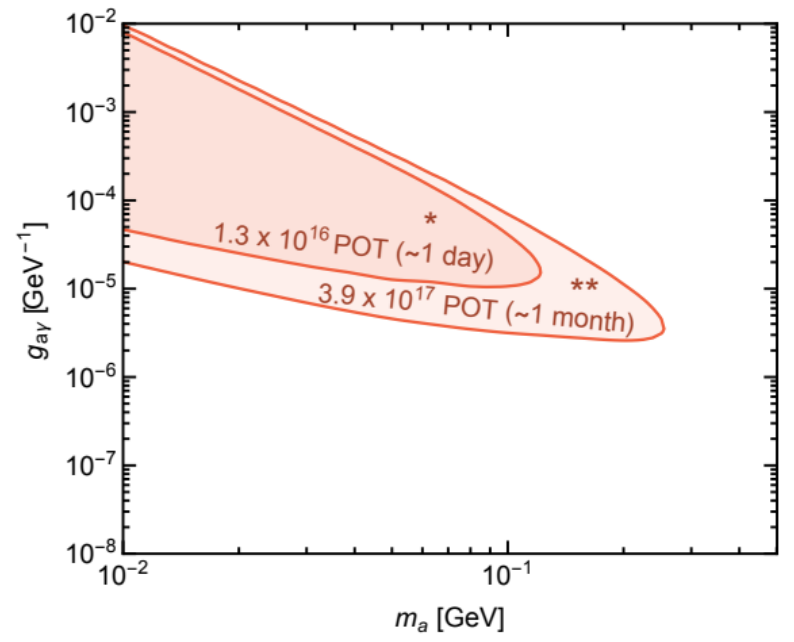
Figure 4. NA62 projected sensitivity, at 90% CL, in the plane coupling vs. Axion-Like Particle (ALP) mass, under the zero-background hypothesis, for a number of Protons On Target (POT) equivalent to one day of beam-dump mode (marked with *) and one month (marked with **)